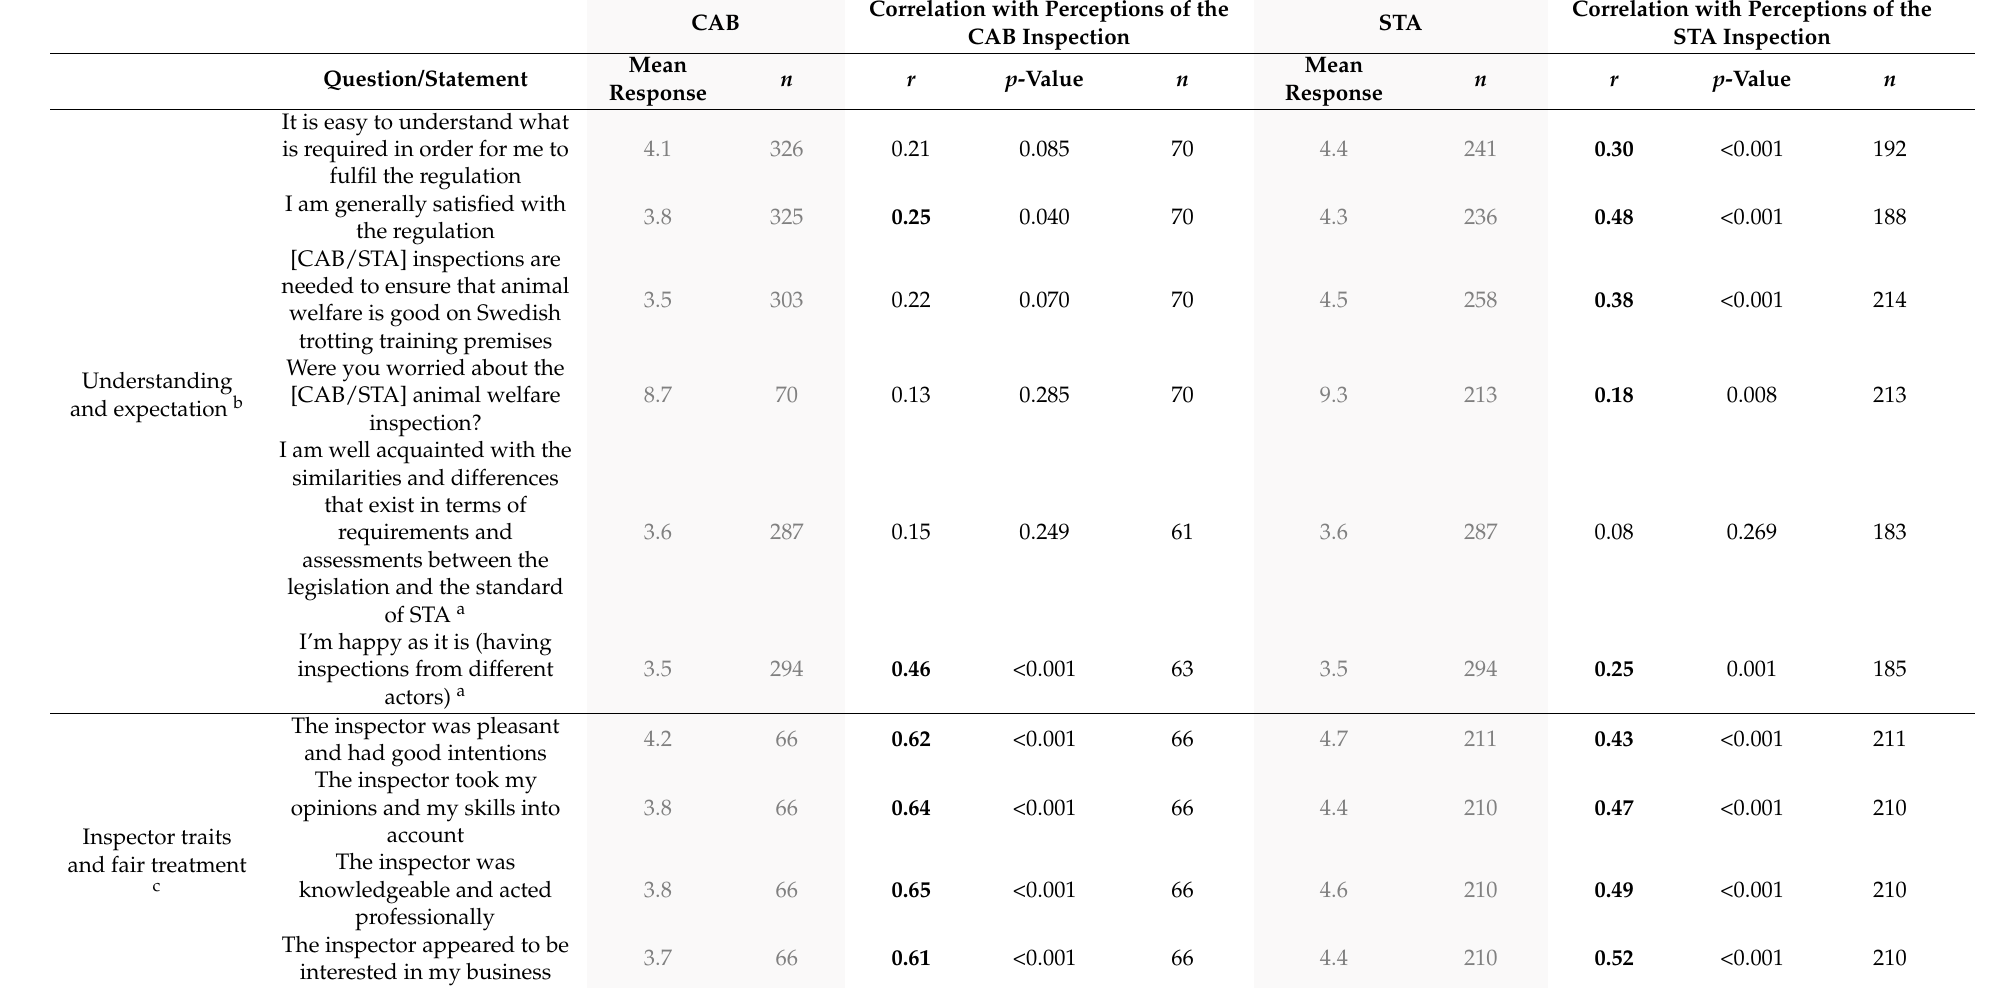
Table 2. Results of correlation tests between graded questions and trainers’ perceptions of County Administrative Board (CAB) and Swedish Trotting Association (STA) inspections. For each question, the mean grading is shown for CAB and STA. Correlation with Perceptions of CAB